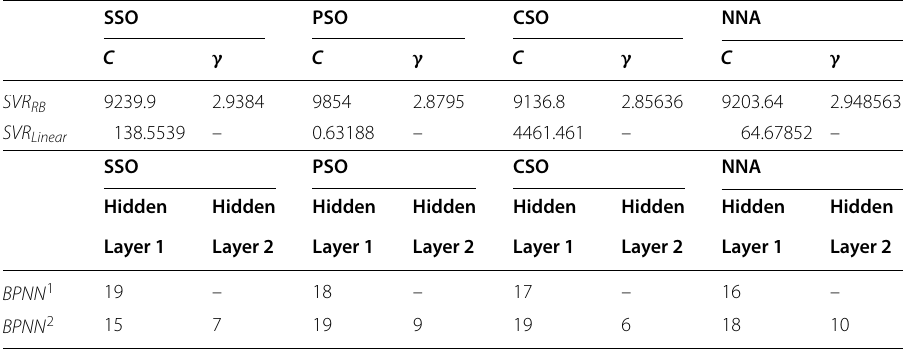
Table 4 Models’ parameters for SVR models and BPNN network configuration (SVR models: ε = 0.001 )